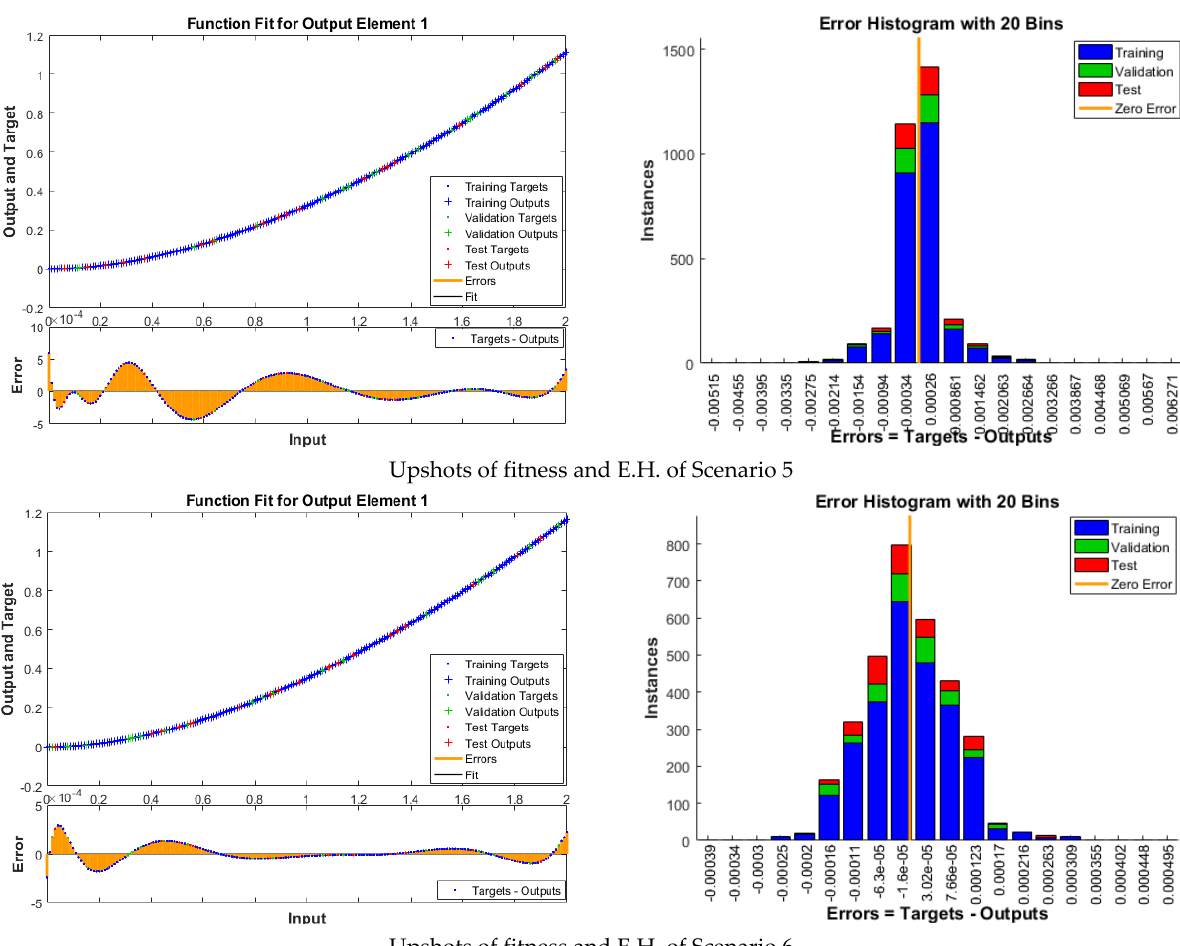
Figure 8. Solution of fitness and error histogram of proposed TLMB-NN for solving HTM-BFN model with MHD for Scenarios 4–6.